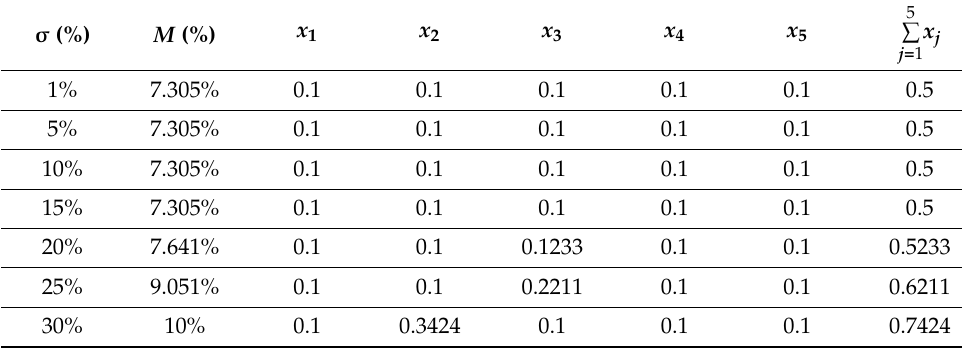
Table 4. The possibilistic efficient portfolios with b = 0.1, p 1 = 0.4, p 2 = 0.2, p 3 = 0.2.